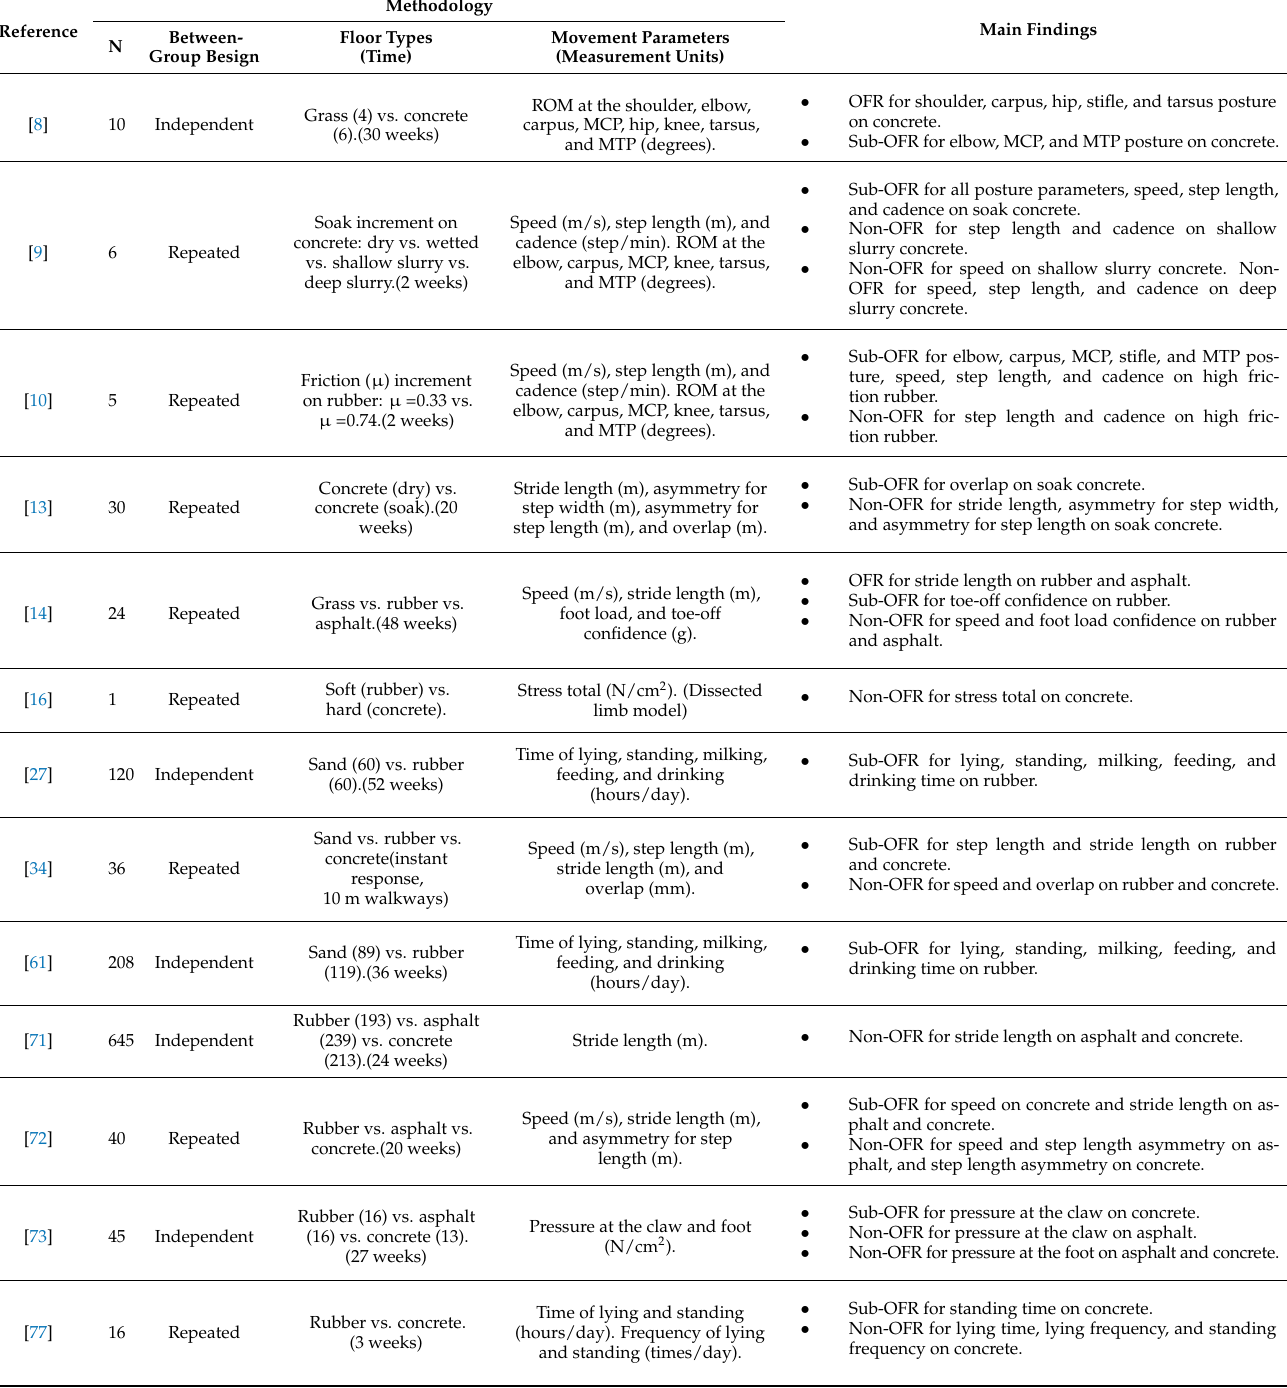
Table 1. Summary of the reviewed literature, the methodology, and the main findings in the light of the integrative analysis of functional